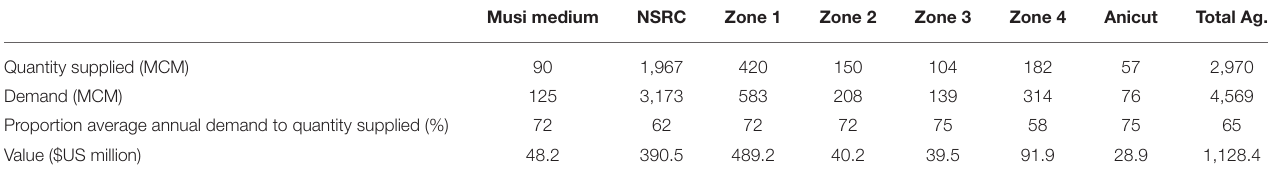
TABLE 1 | The annual quantities of bulk water reliably supplied at the 80% levels of reliability in each region and the net returns for water used in each region. Musi medium NSRC Zone 1 Zone 2 Zone 3 Zone 4 Anicut Total